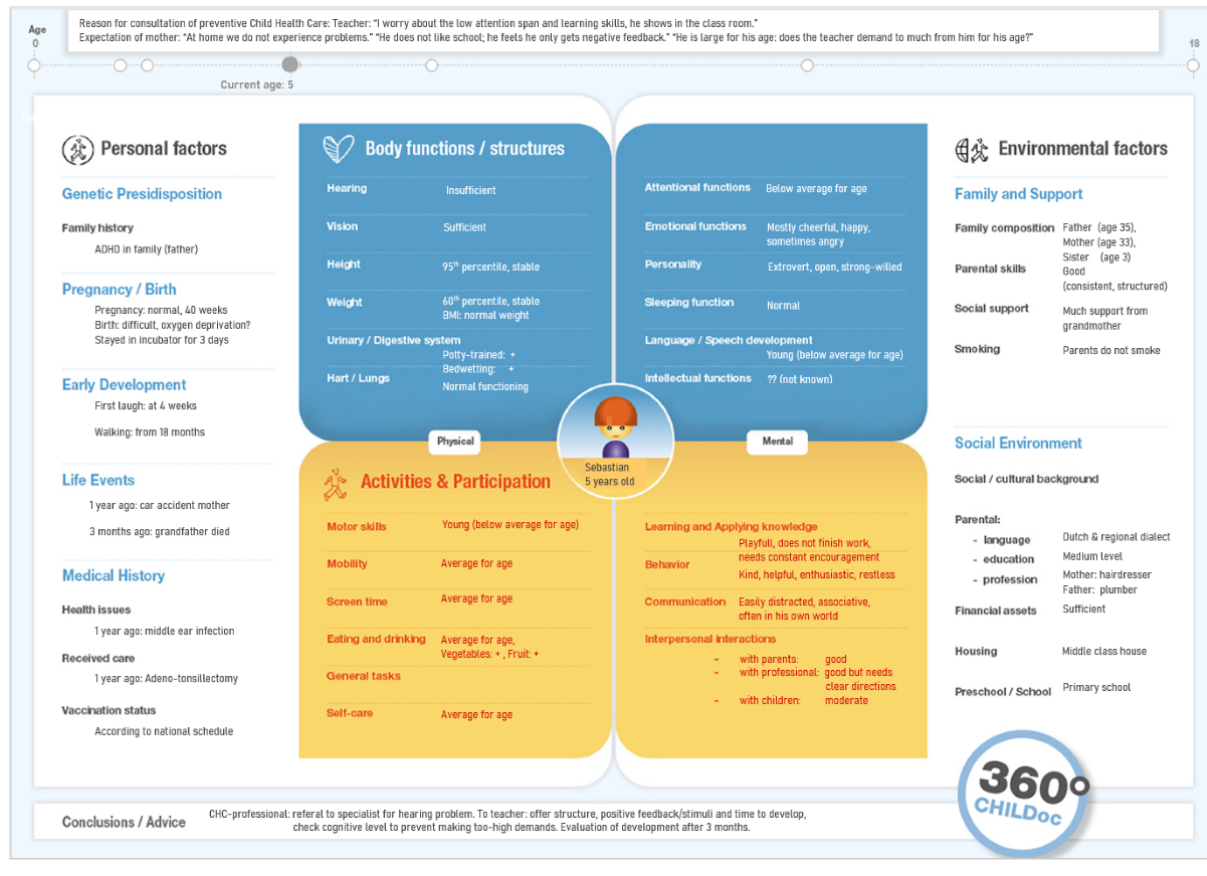
Figure 1. The 360°CHILD-profile: representation of a child’s health information available in the CHC electronic medical dossier, based on the "International Classification of Functioning, Disability and Health for Children and Youth” [10]. Child’s name, gender, and age appear in the center; the most recently acquired data about the child’s body functions and structures in physical and mental aspects appear in the blue area; and information on activities and participation appear in the yellow area. Data about genetic predisposition and history (medical, developmental, and life events) are listed in the left column, and information about environmental factors are in the right column. On top of the 360ºCHILD-profile, a timeline is provided with bullet points at which ages the child visited CHC, and a CHC and a 360ºCHILD-profile (snap-shot) is generated. At the bottom of the 360ºCHILD-profile, conclusions and advice from the most recent CHC visit are presented. CHC: child health